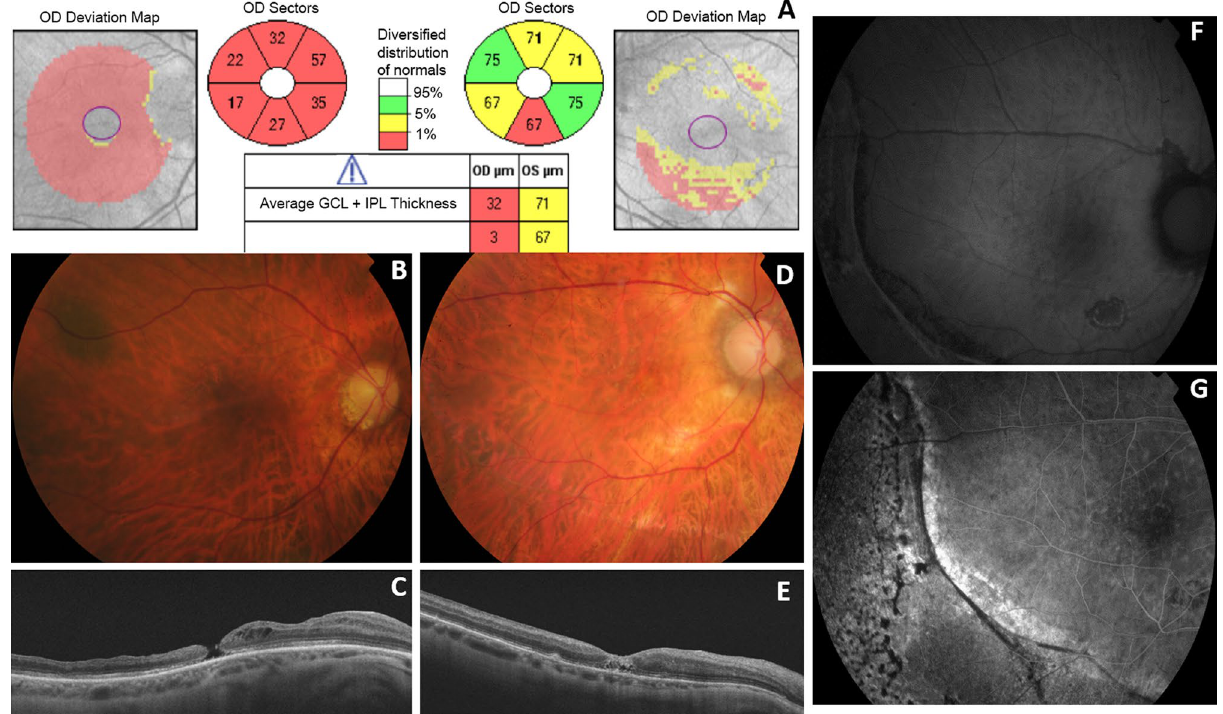
Figure 1. Clinical pictures from two Spanish patients. One Spanish patient showed evidence of optic nerve atrophy on the OCT ( A ) and in the ocular fundus ( B ), and a postoperative macular hole ( C ). On the right- hand side, the fundus of another Spanish patient showed signs of retinal and optic nerve atrophy and highly stenotic vessels ( D ); there is foveal disruption on the OCT ( E ) and pigmentary changes at the edge where octane contacted with the retina is also evident on autofluorescence ( F ) and angiofluorescein images ( G